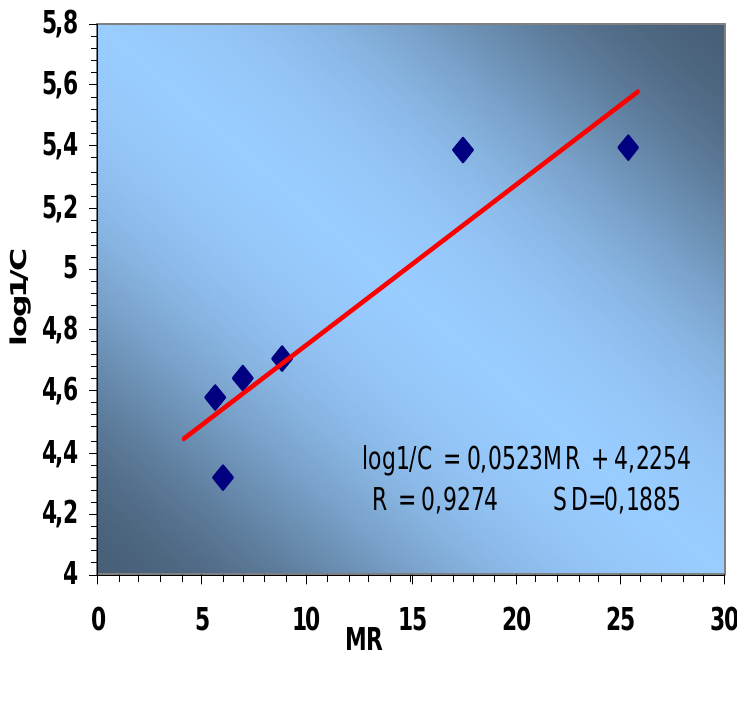
Figure 3. Linear correlation between log 1/C and